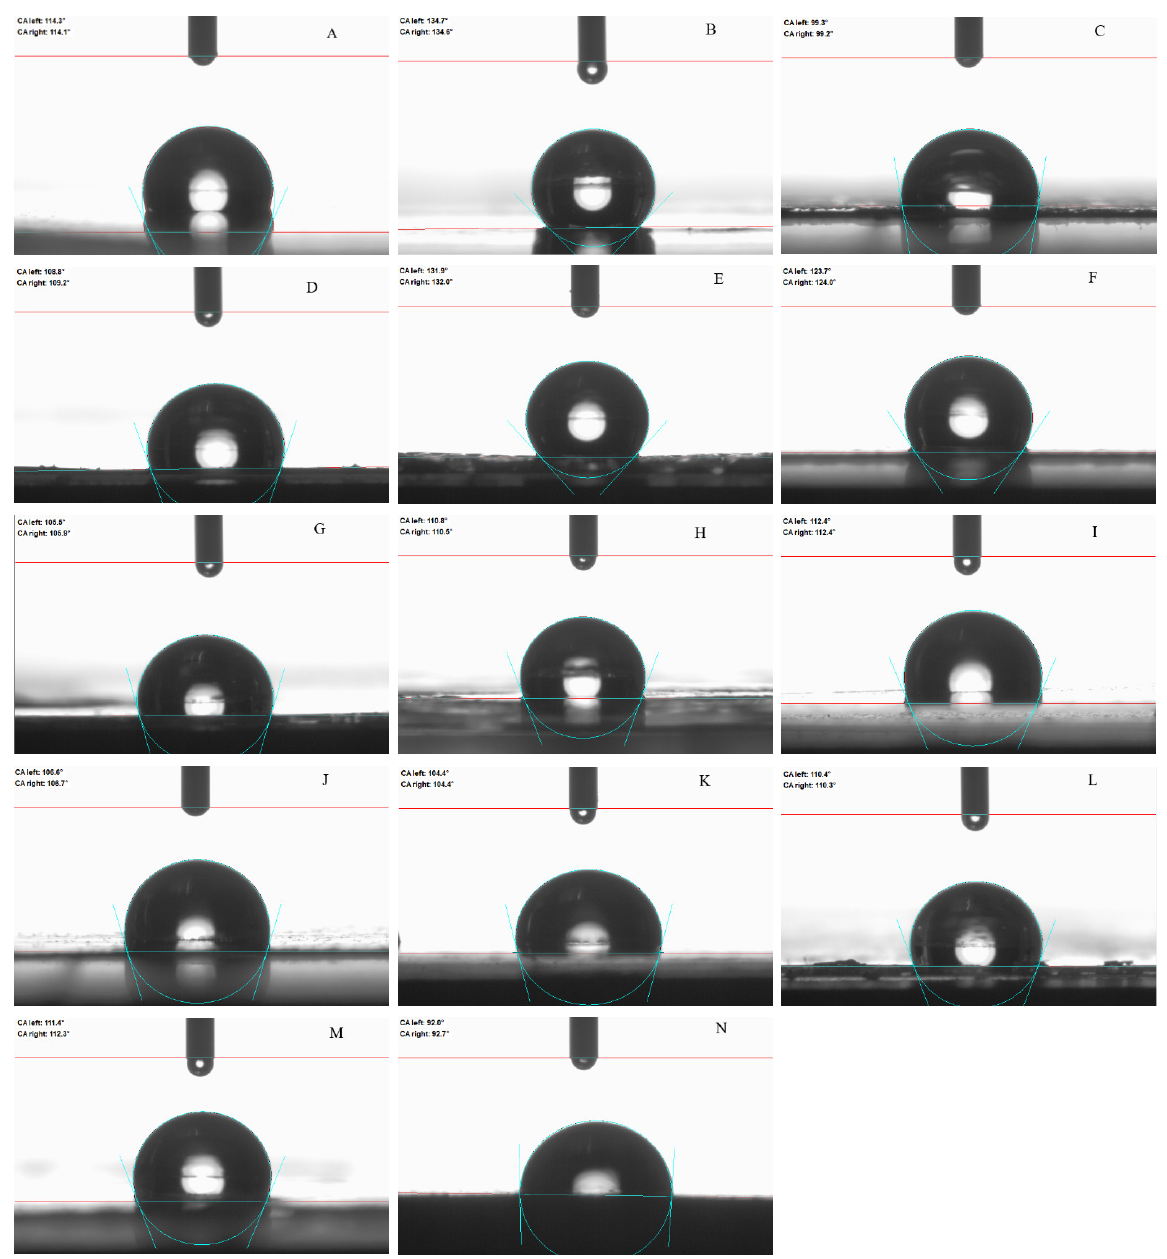
Figure 3. Water contact angle of the transdermal patch (TP): A ) without active substance (DT54); ( B ) with the ibuprofen (IBU); ( C ) IBUNa; ( D ) GlyIBU; ( E ) AlaIBU; ( F ) ValIBU; ( G ) SerIBU; ( H ) ThrIBU; ( I ) AspIBU; ( J ) LysIBU; ( K ) LysIBU 2 ; ( L ) PheIBU; ( M ) ProIBU; and ( N ) commercial product. The lower contact angle possesses higher hydrophilicity and the higher contact angle lower hydrophilicity. The contact angle was 94.2 ± 1.3° for the commercial patch and 134.7 ± 0.9° for the patch containing ibuprofen (IBU). In general, the addition of the active in- gredient in the form of an isopropyl amino acid ester salt reduces the contact angle. This is most likely due to an increase in the hydrophilicity of the active substance through its